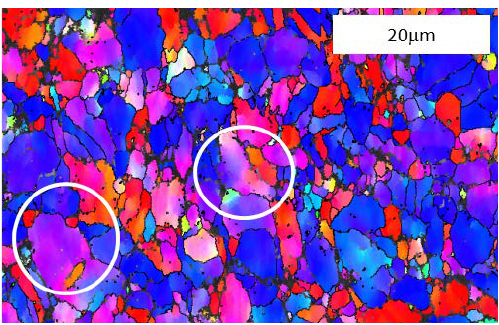
Figure 11. High magnification inverse pole figure (IPF) map taken from the axial plane indicating intra-grain misorientation (examples within circled regions).